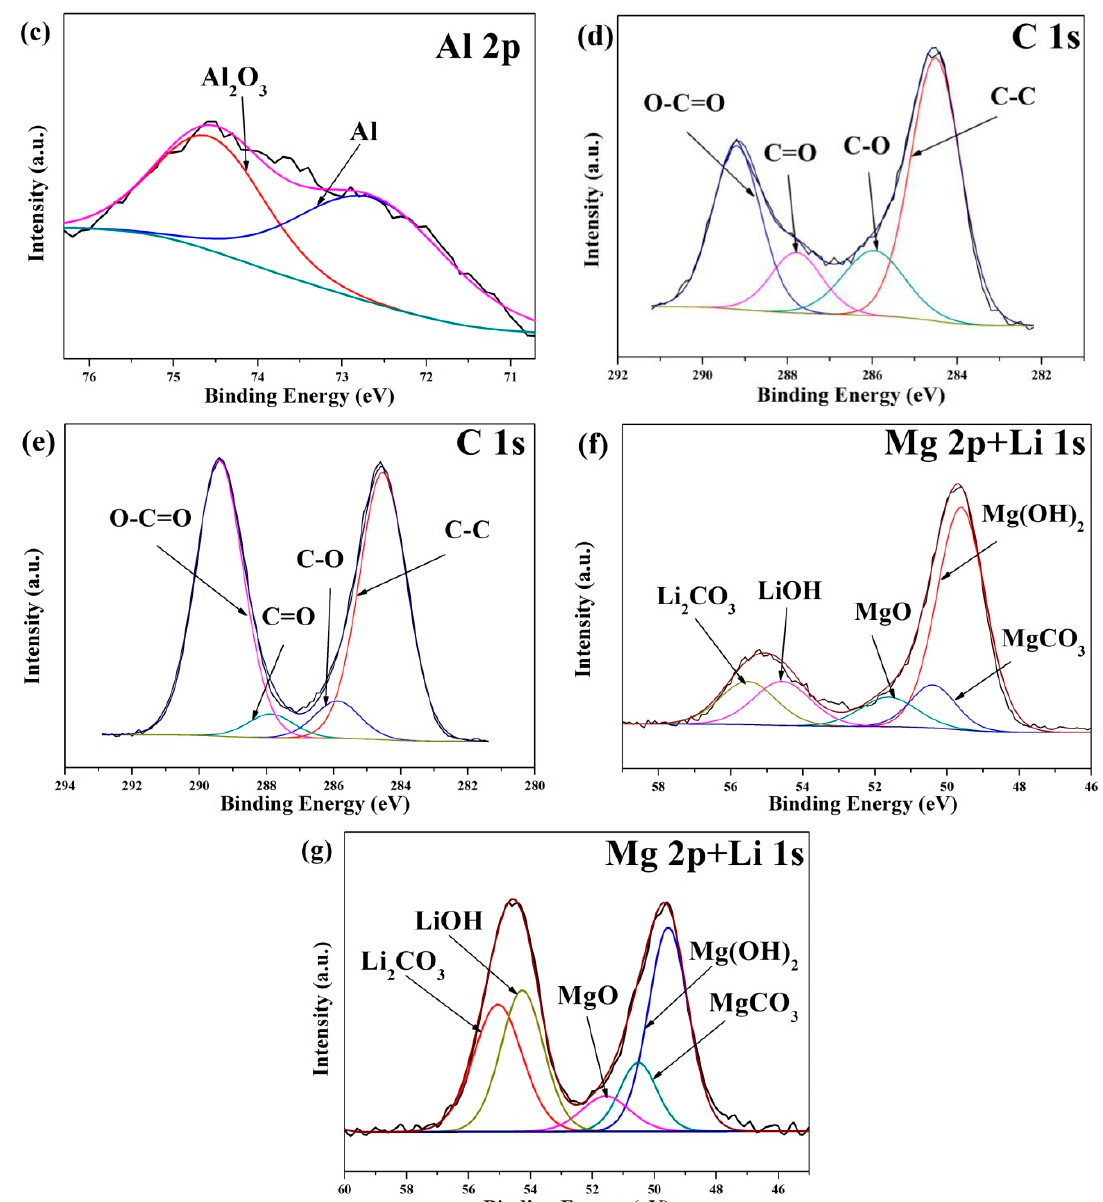
Figure 7. XPS analysis of ( b , d , f ) LA143 Alloy, and ( a , c , e , g ) YAl 2p /LA143 composite, after immersion test in 3.5 wt.% NaCl solution.